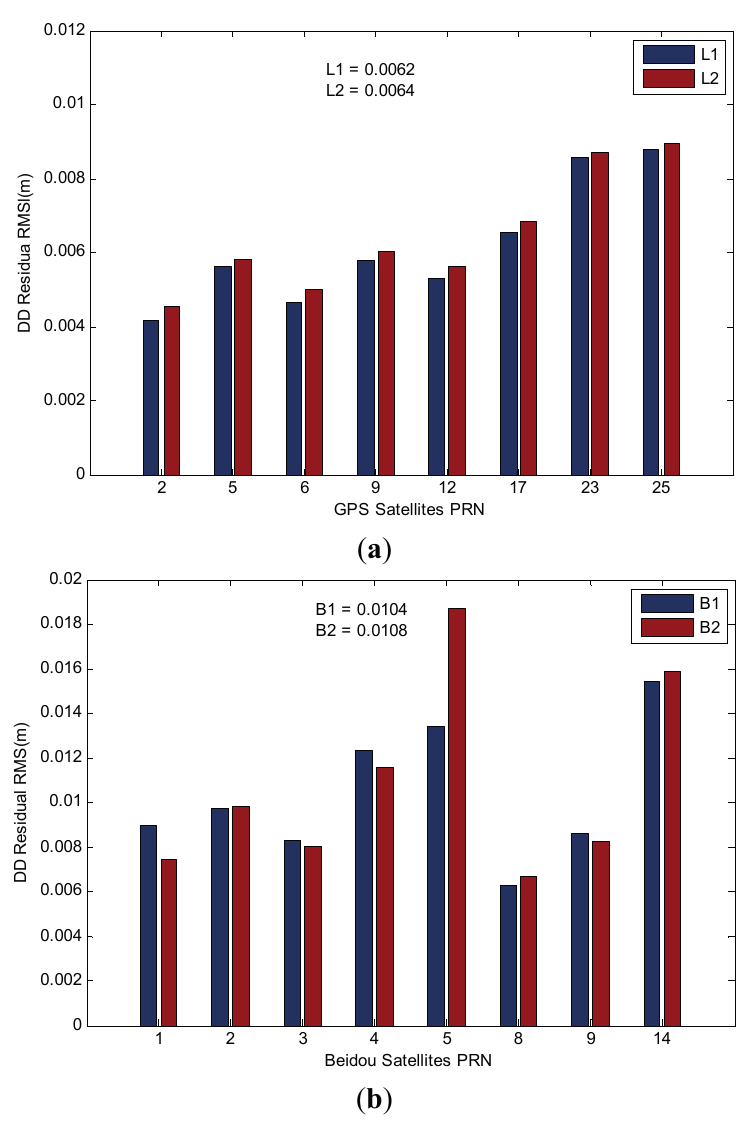
Figure 20. ( a ) RMS values of GPS DD residual; ( b ) RMS values of BDS DD